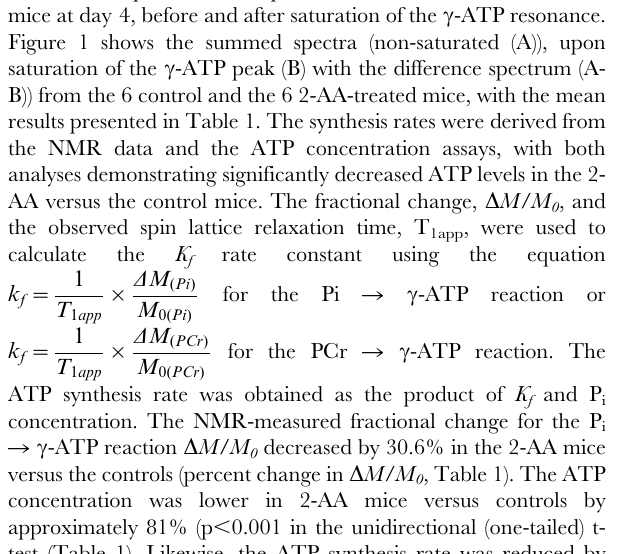
Gene Bank Accession